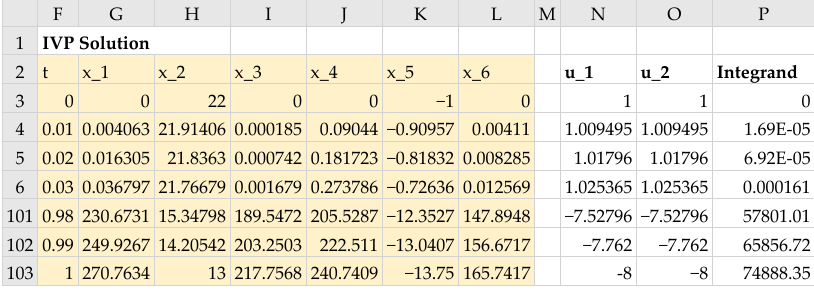
Figure 15. Partial listing of computed result by Formula (30). Also shown are generated control and integrand columns. The associated formulas are listed in Table 3.